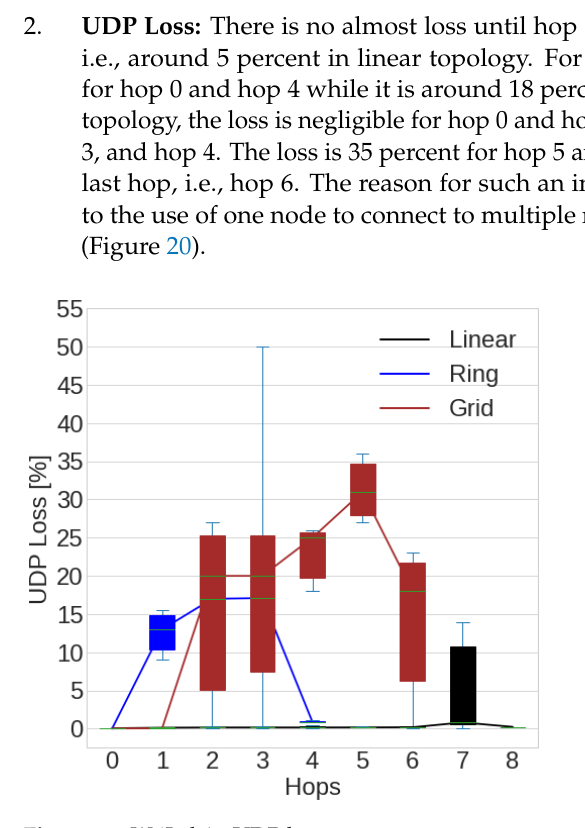
Figure 20. W-iLab1.t UDP